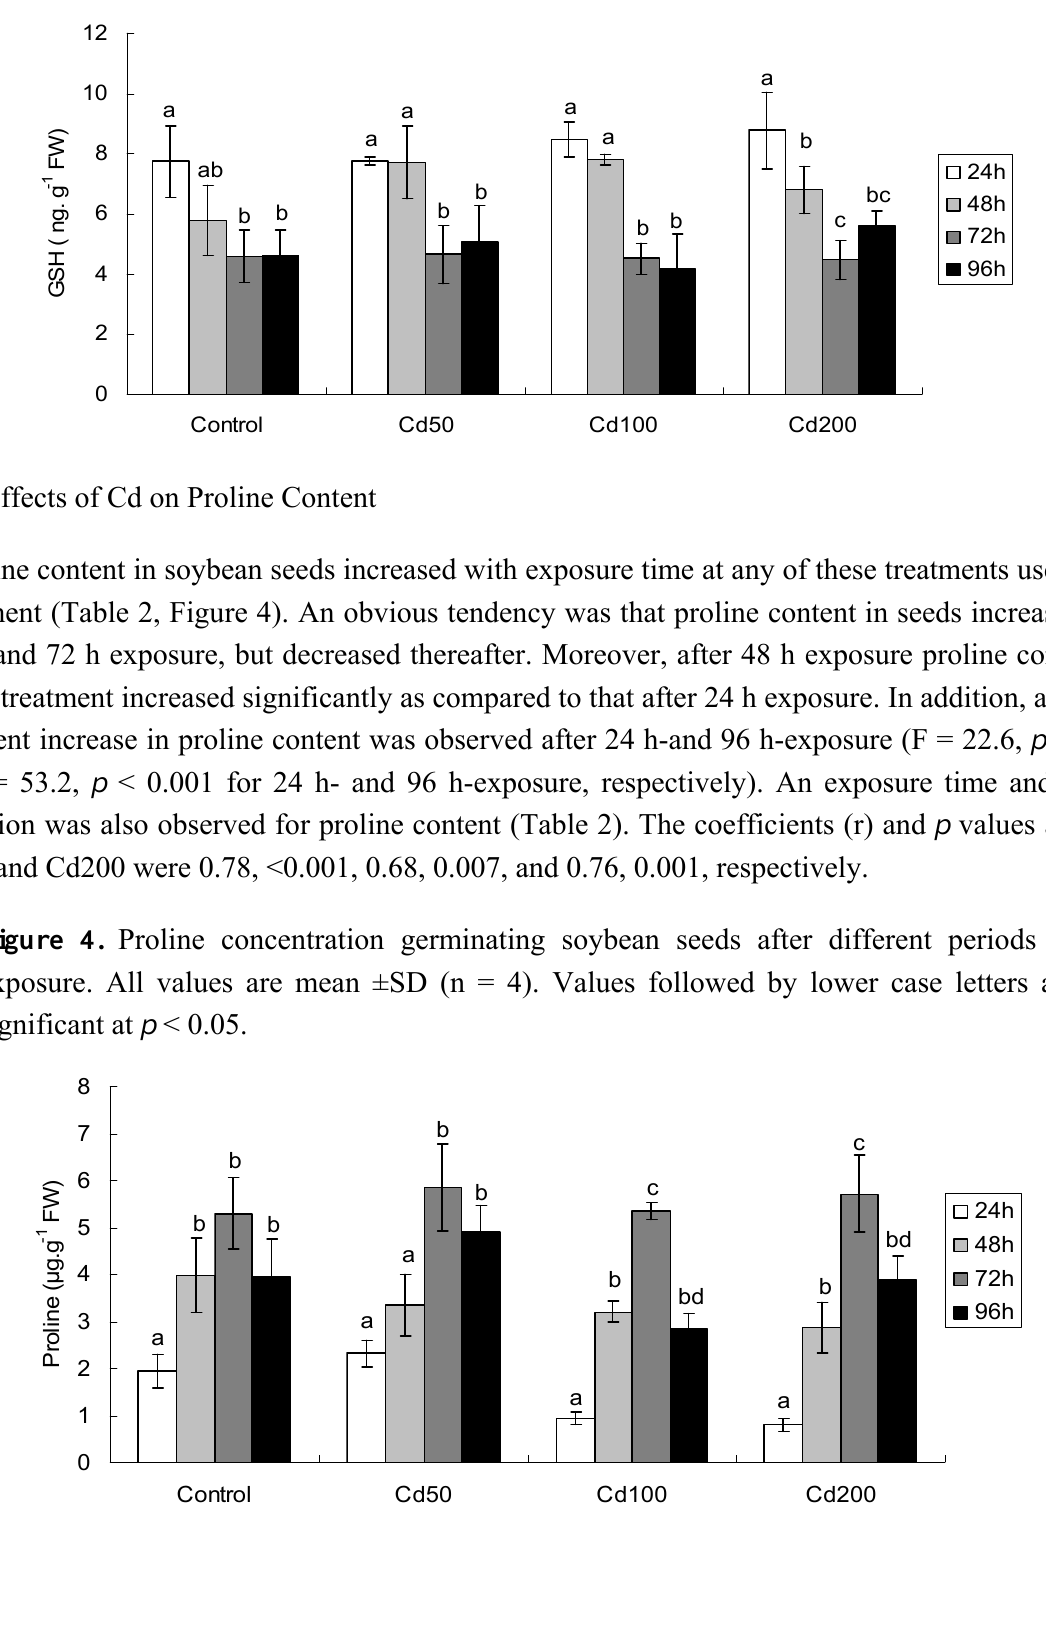
Figure 3. GSH/hGSH concentration in germinating soybean seeds after different periods of exposure. All values are mean ± SD (n = 4). Values followed by lower case letters are significant at p < 0.05.